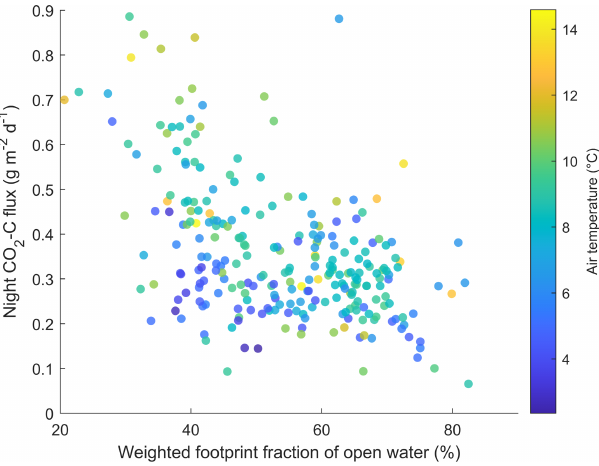
Figure 3. Scatterplot of observed CO 2 fluxes against the weighted footprint fraction of open water during each 30min flux. The air temperature is represented through color. Only fluxes observed in the nighttime (PAR < 20µmolm − 2 s − 1 ) are